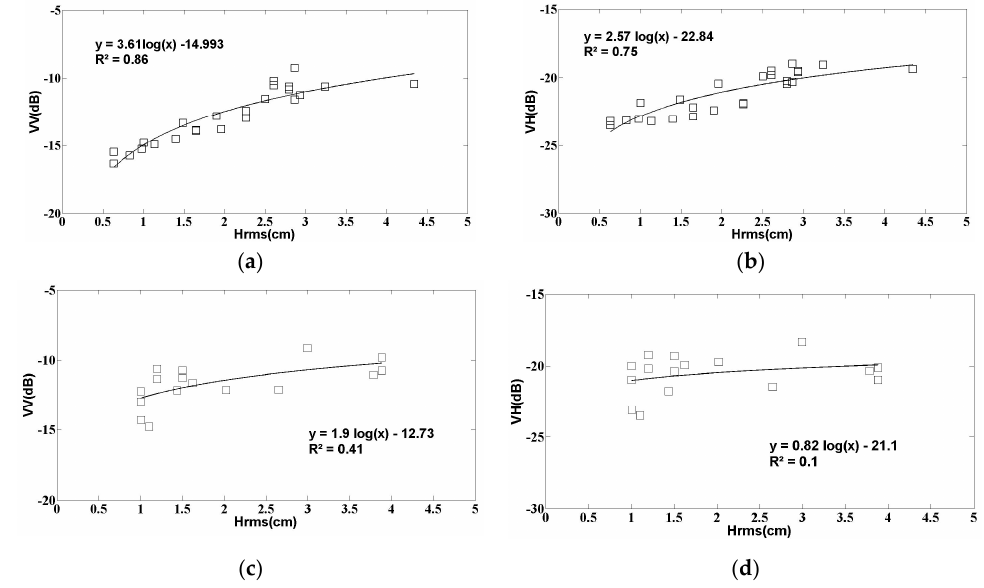
Figure 7. S1 radar data as a function of the Hrms roughness parameter in two soil moisture (mv) classes: ( a ) VV polarization, mv ≤ 10 vol. %; ( b ) VH polarization, mv < 10 vol. %; ( c ) VV polarization, 10 vol. % < mv < 20 vol. %; ( d ) VH polarization, 10 vol. % < mv < 20 vol. %.